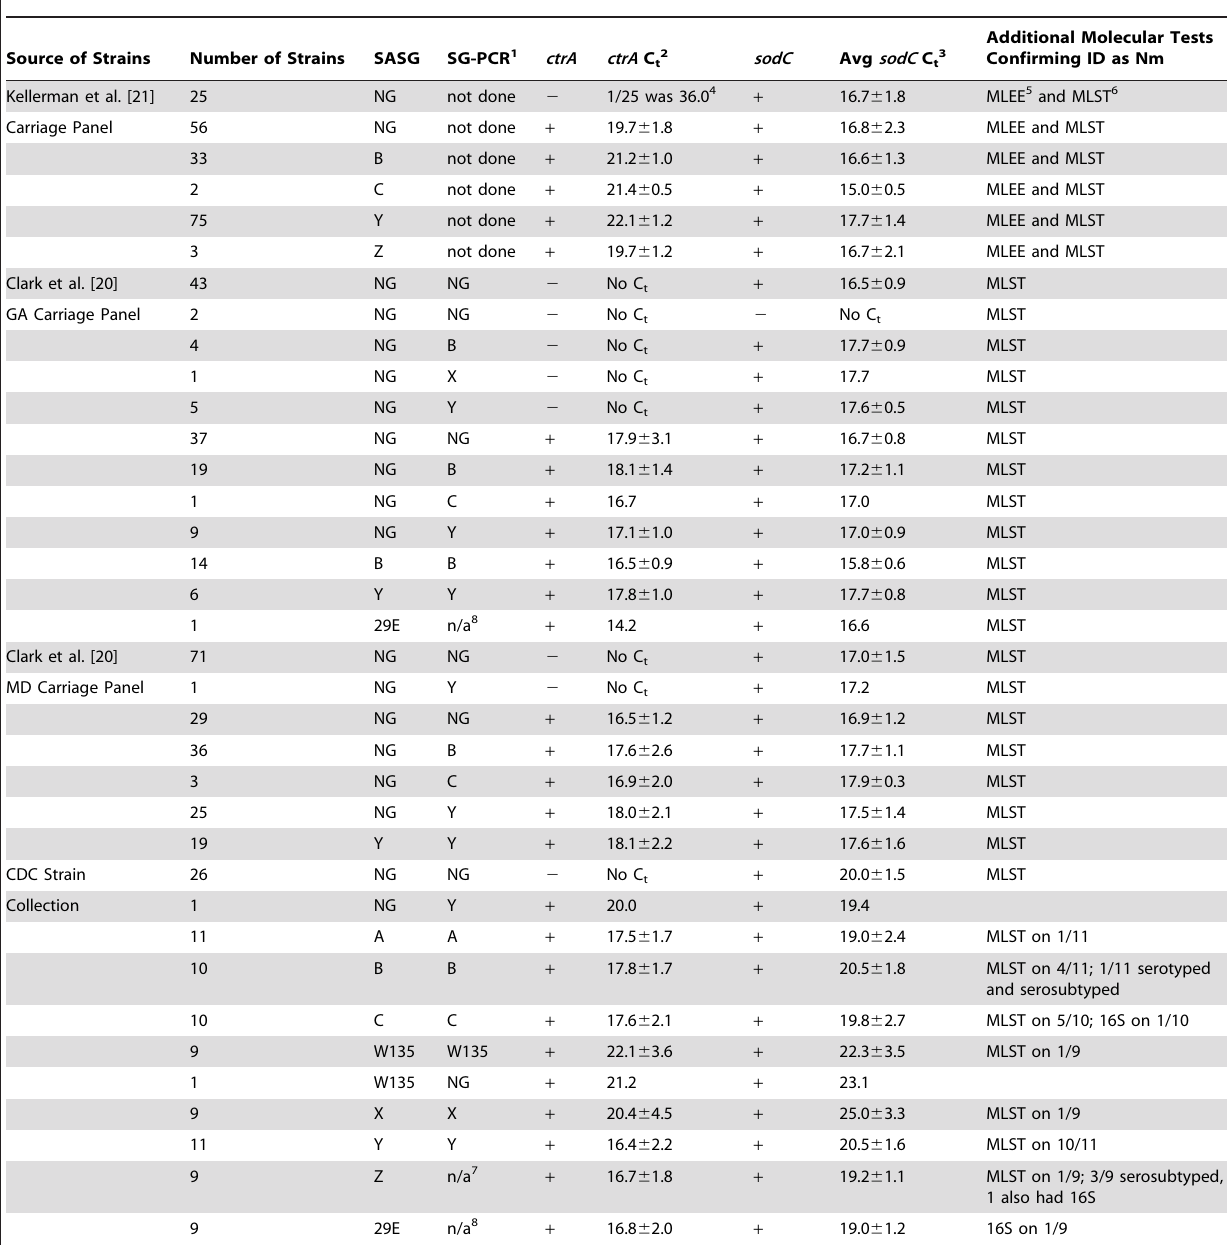
Table 1. Summary of 626 Nm isolates used to test the sensitivity of the sodC assay.